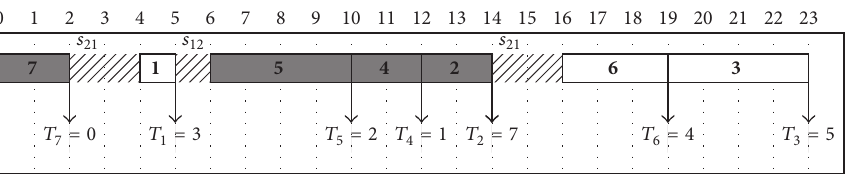
Figure 1: A schedule S = { 7 , 1 , 5 , 4 , 2 , 6 , 3 }